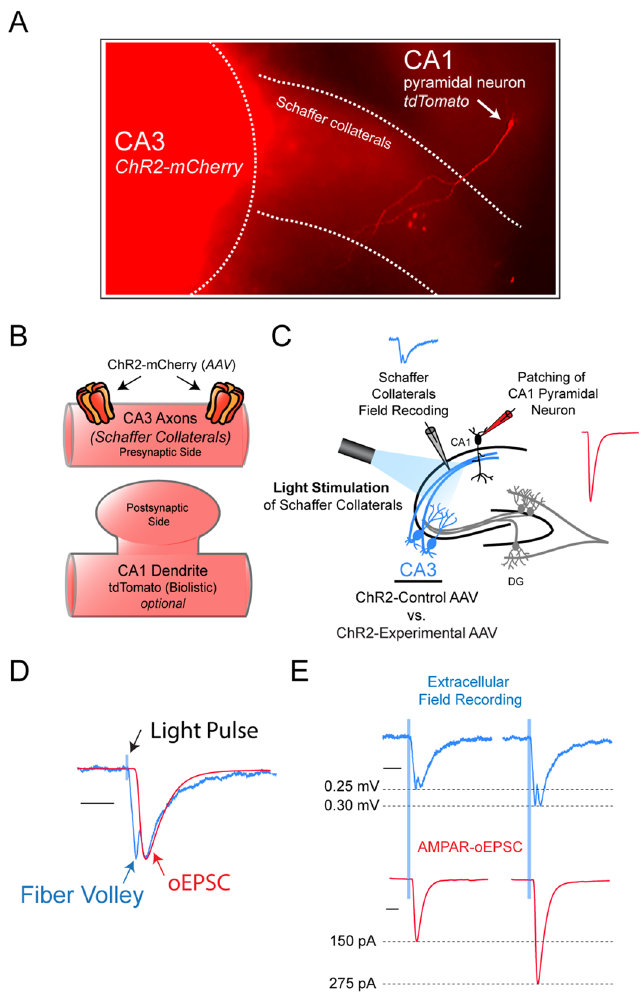
Figure 1. Method setup. ( A ) Image of rat hippocampal slice culture setup for recording CA1 pyramidal neuron currents with optical stimulation of Schaffer collaterals. The CA3 region was injected with an AAV expressing ChR2 tagged with mCherry, and mCherry fluorescence can be seen in both the CA3 pyramidal neuron cell bodies and axons (Schaffer collaterals). A biolistically transfected CA1 pyramidal neuron is also visible by its tdTomato fluorescence. ( B ) Schematic illustration of a CA3-CA1 synapse in our setup. ChR2-mCherry is expressed in the presynaptic Schaffer collaterals via AAV virus, and biolistically-transfected tdTomato is optionally expressed postsynaptically in the CA1 pyramidal neuron. ( C ) Schematic illustration of experimental setup. Virally transduced CA3 pyramidal neurons expressing ChR2 are stimulated optically using 470 nm blue light to evoke a postsynaptic response in CA1 pyramidal neurons. Whole-cell recordings of a CA1 pyramidal neuron were made simultaneously with extracellular field recordings in the Schaffer Collaterals. ( D ) Optically- induced extracellular field recording trace (blue) merged with postsynaptic whole-cell recording trace (red), verifying that the two traces align in time and illustrating the presynaptic fiber volley. Scale bar: 20 ms. ( E ) Presynaptic fiber volley amplitude and postsynaptic current amplitude scale with light stimulus intensity. Scale bar: 20